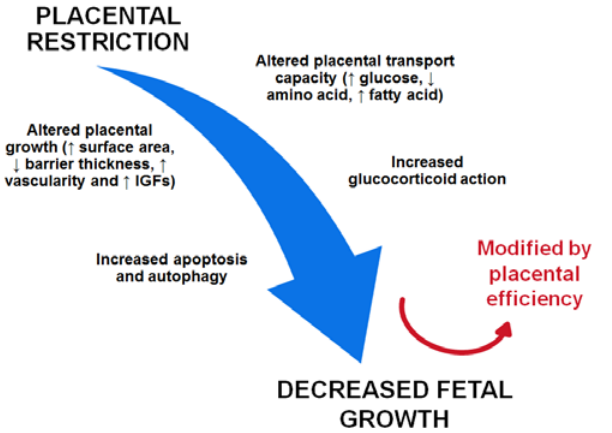
Figure 1. Summary of the placental adaptations that occur in the placental insufficiency-induced IUGR fetus and contribute to decreased fetal